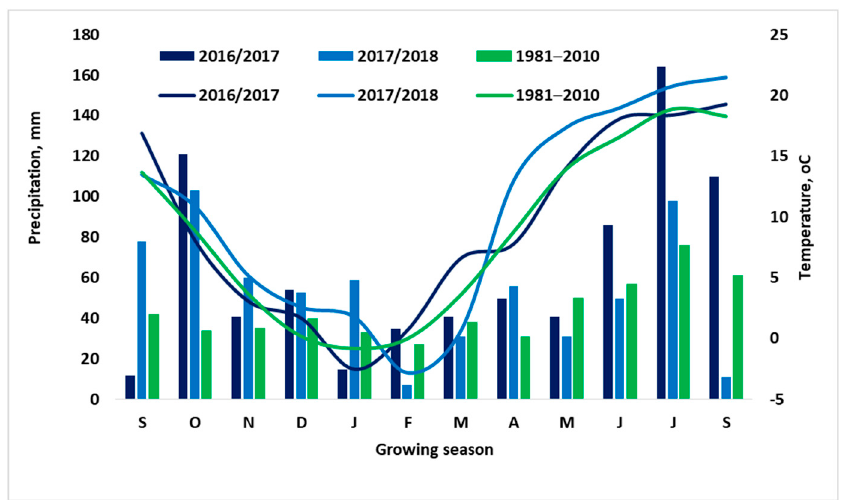
Figure 1. Meteorological conditions during the growing season of winter wheat. Source of data: Competence Center weather station BASF Jarosławiec and Pami ˛atkowo, http://www.pogodynka.pl/ polska/daneklimatyczne/ (accessed on 20 December